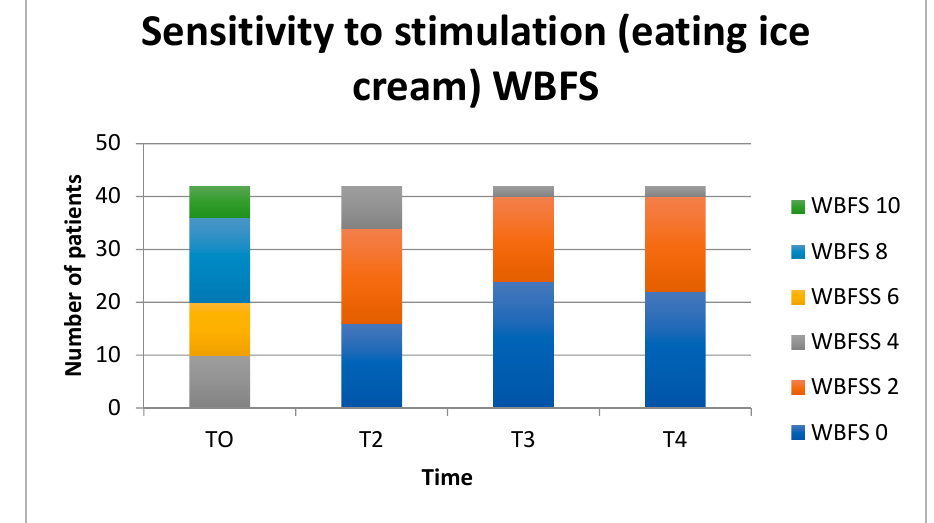
Figure 3. WBFS sensitivity test eating ice cream. Significant differences of sensitivity according to the SCASS scale (Figure 4) were reported between T0 and all subsequent follow-ups, p < 0.05.